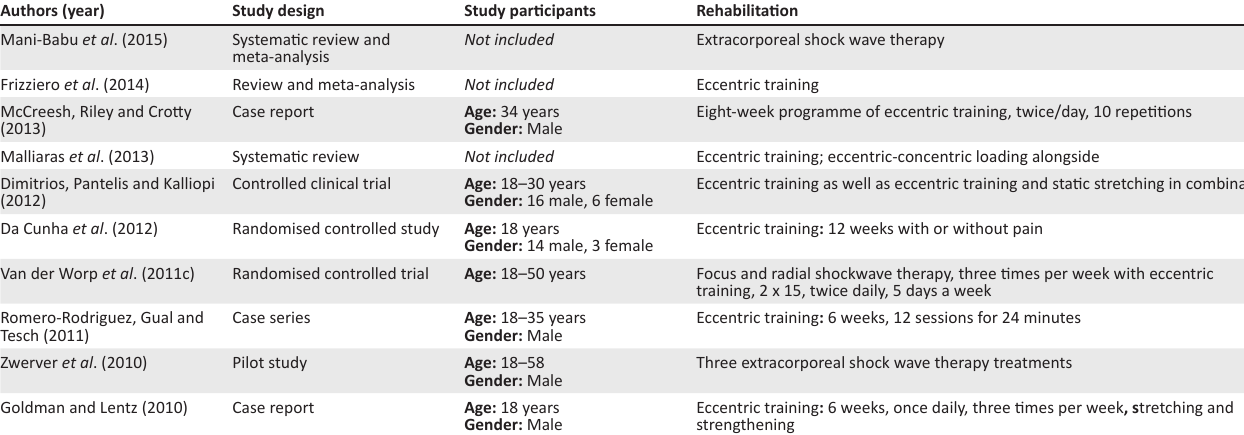
TABLE 3: Rehabilitation of patellar tendinopathy.